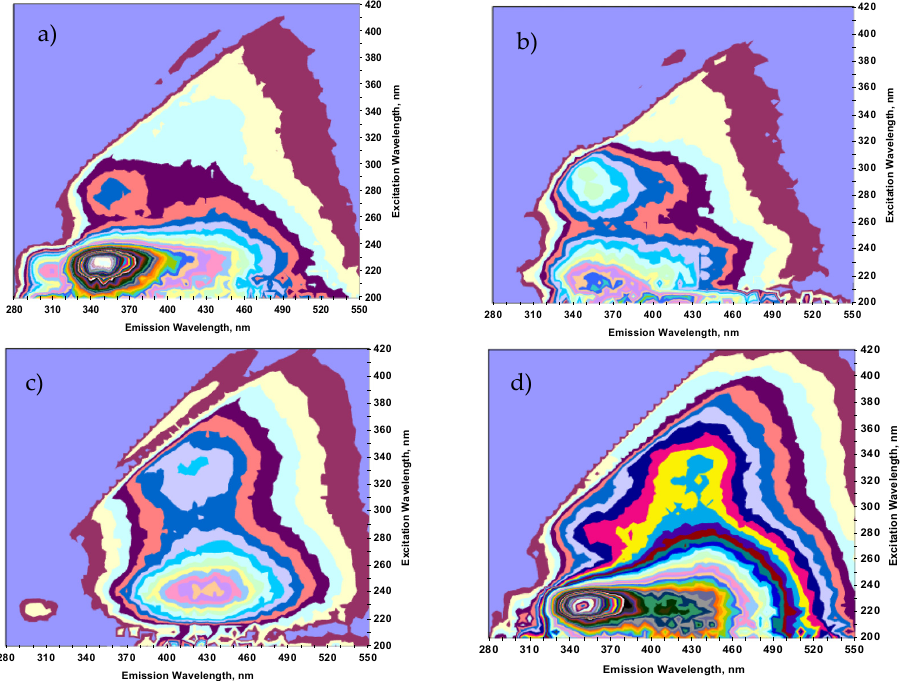
Figure 8. Excitation-Emission Matrix of the groundwater samples from the Municipality of Texcalyacac: ( a ) S1 (Type I), ( b ) S2 (Type I), ( c ) S3 (Type II), ( d ) S4 (Type III). cac: ( a ) S1 (Type I), ( b ) S2 (Type I), ( c ) S3 (Type II), ( d ) S4 (Type With the 3D fluorescence spectra obtained, the anthropic origin of the dissolved